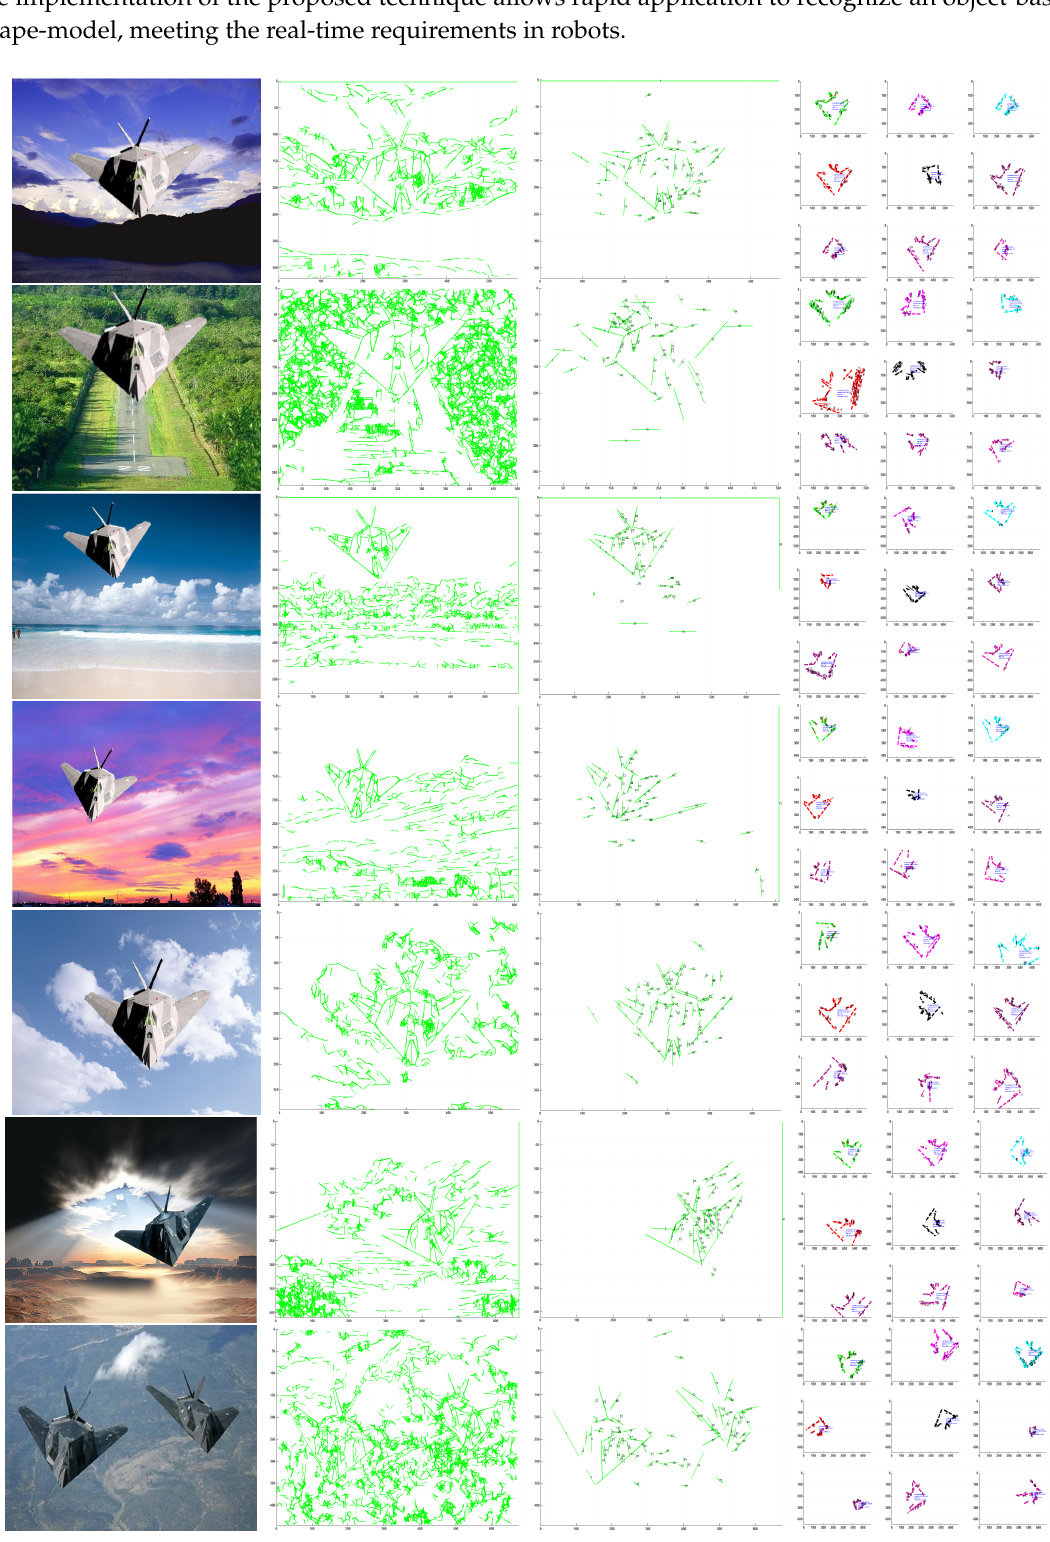
Figure 11. More experiments were performed on a dataset of images with various complicated